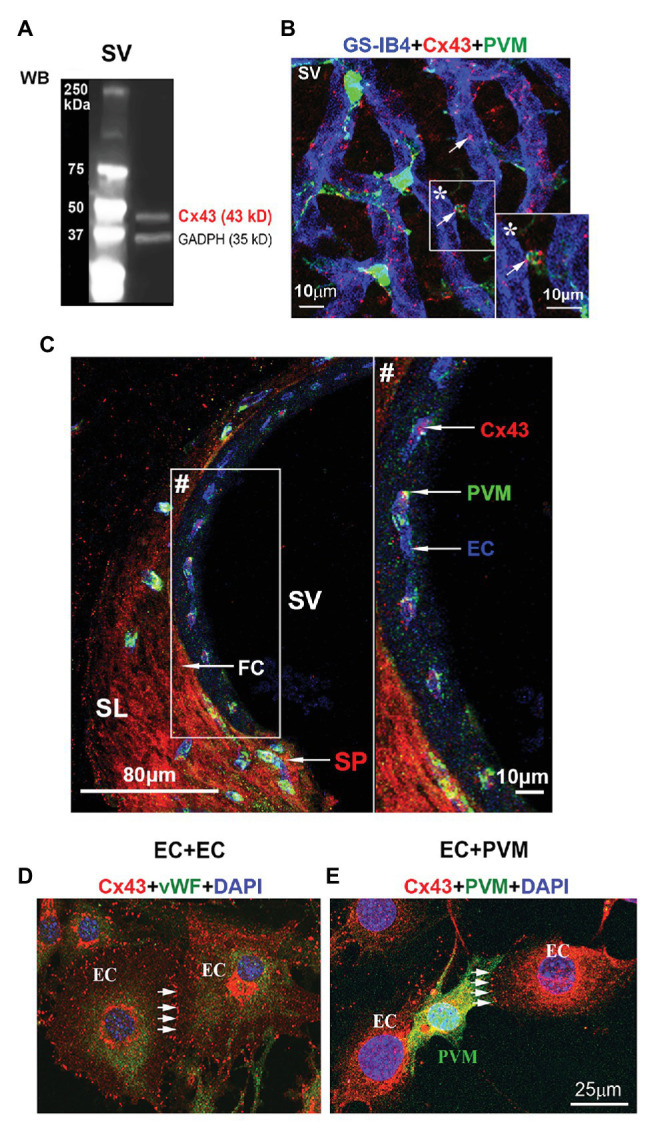
Connexin 43 (Cx43) immunoreactivity detected in the stria vascularis and spiral prominence (SP), and in primary cell lines. (A) Western blot analysis shows Cx43 protein tissue expression in the stria vascularis. (B) The confocal image of triple immunolabeled cells using antibody for Cx43 to show Cx43-positive spots predominately expressed in blood vessels [labeled with Griffonia simplicifolia IB4 (GS-IB4) conjugated to Alexa Fluor 647] and end-feet of PVMsGFP (green) in a whole-mount surface preparation of the stria vascularis. (C) The confocal projection image shows that Cx43 in the SP (SP/arrow) is primarily expressed in endothelial cells (ECs/arrow) and fibrocytes (FCs/arrow) in a cross-section preparation of the cochlear lateral wall. (D) The confocal projection image further shows Cx43 expression at the contact border between ECs labeled with antibody for von Willebrand factor (green), an EC marker protein. (E) The confocal projection image shows Cx43 expression at the contact border between ECs and PVMsGFP (green). SV, stria vascularis; SL, spiral ligament; SP, spiral prominence; PVM, perivascular resident macrophage; EC, endothelial cell; FC, fibrocyte. * is the magnified insert image of Cx43 expression in the EC-PVM contacts. # is the zoomed image of Cx43 expression from an insert in panel (C).